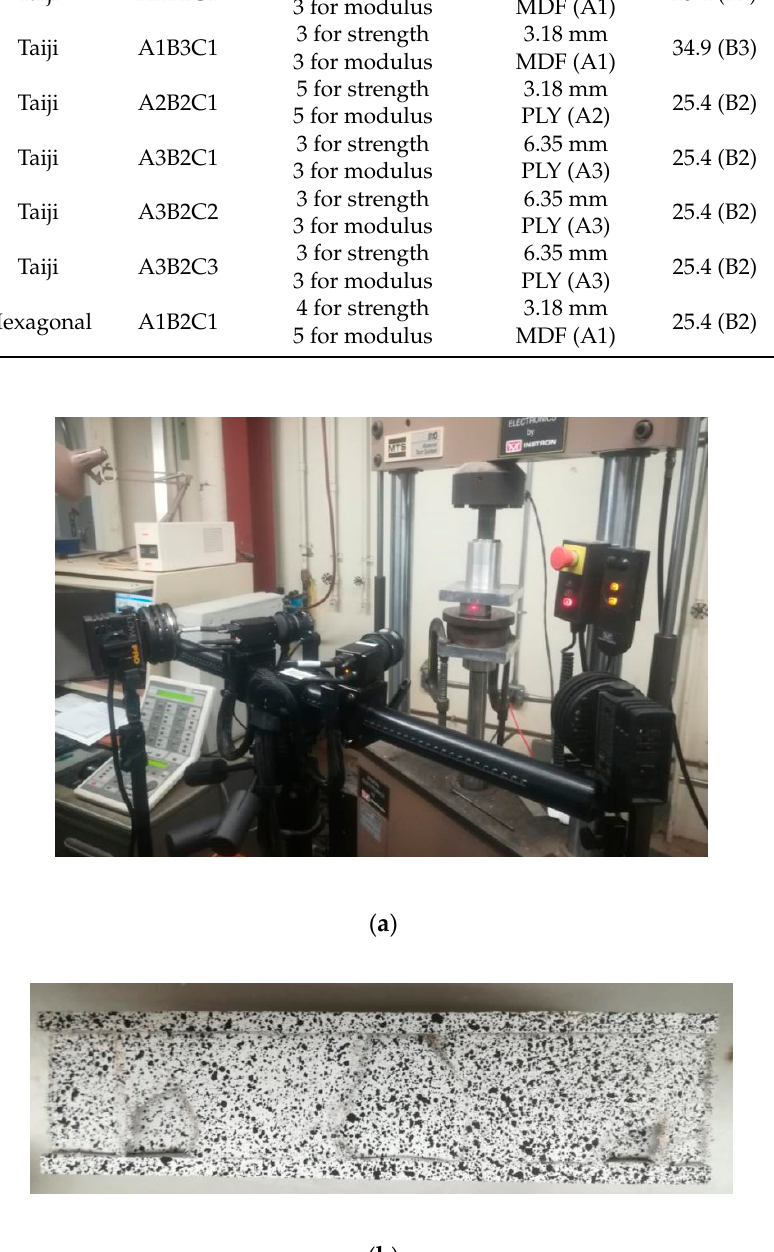
Figure 2. Three-dimensional digital measurement system. ( a ) Measurement set-up; ( b ) paint on the surface of the specimens.